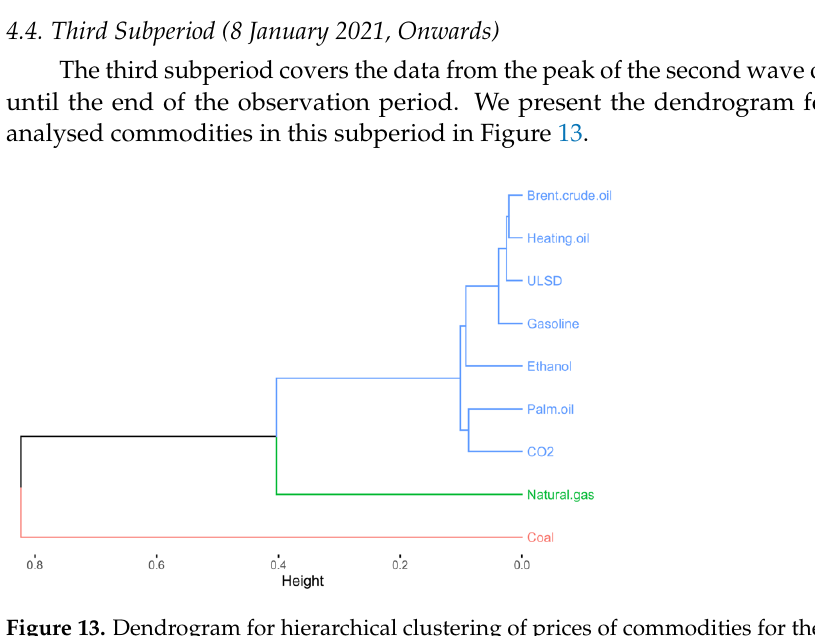
Figure 13. Dendrogram for hierarchical clustering of prices of commodities for the third sub- period. Source: own elaboration on the basis of data from www.stooq.com (accessed on 19 April 2021). There are three visible clusters for the third subperiod. Two of them have just one member — coal and natural gas. All remaining commodities form the third, rather homo- geneous cluster. The reason for this is that while the coal price is in this subperiod de- creasing with high fluctuations, the natural gas price increases and then decreases, and the prices of all other commodities are generally increasing throughout the whole sub- period. We obtain the same results for the k -medoids and divisive hierarchical clustering methods.